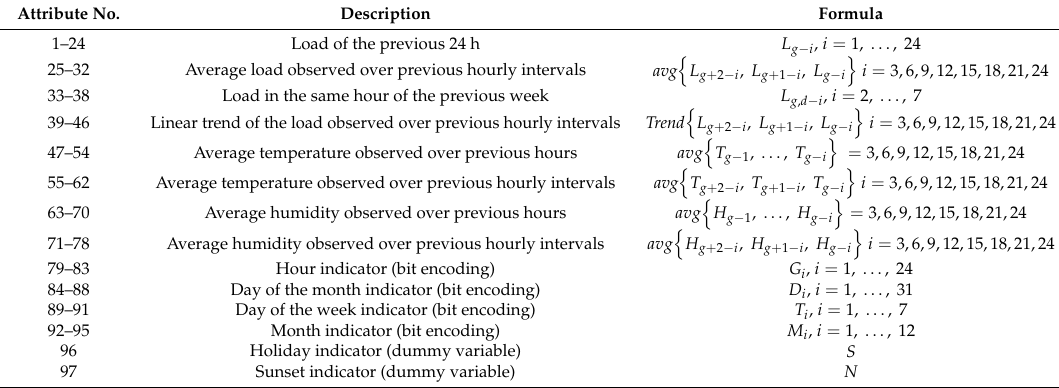
Table 1. Feature vector used for estimating the